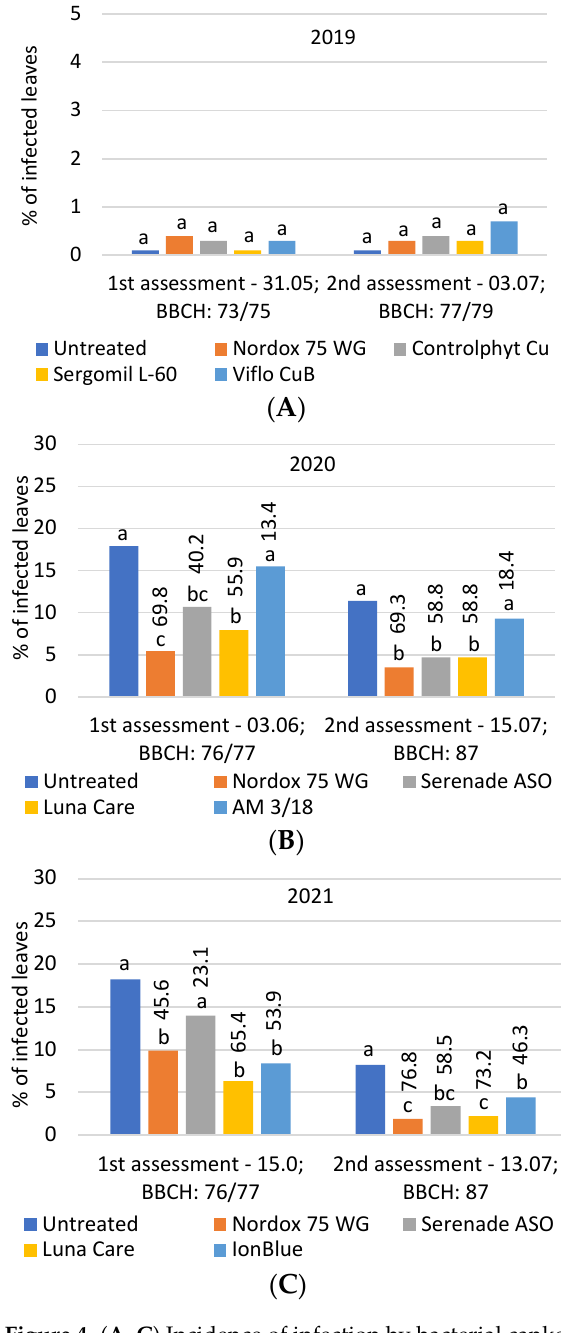
Figure 3. ( A – C ) Incidence Figure 4A–C. Incidence of infection by bacterial canker (caused by P. sy- ringae ) on leaves of plum after foliar applications of different products during the flowering period in 2019–2021. Efficacy values are shown above each bar. The means marked by the same letter do not differ according to the Newman-Keuls test at the 5% significance level.